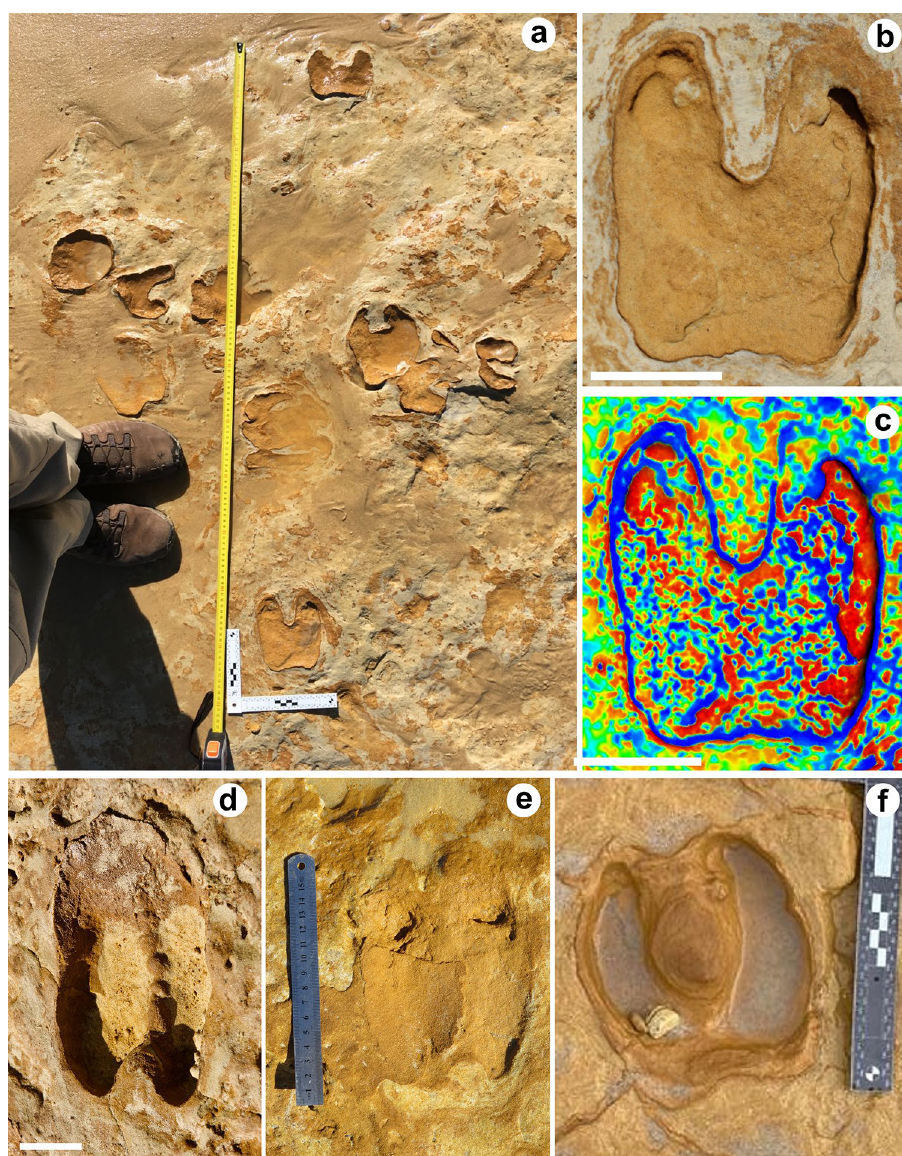
Figure 6. Large artiodactyl tracks from the MTS. ( a ) Trackway T1 attributed to aurochs based on the large size of the squared tracks and the preservation of the dewclaws as rectangular imprints; ( b ) 3D model of a tetradactyl track from the MTS interpreted as Bovinichnus uripeda , vertical view of the texturized 3D model in natural colours; ( c ) vertical view from the previous track made of the false colours DSM (cold and hot colours represent depth gradient, from deeper to shallower, respectively); ( d ) Bovinichnus uripeda , large track; ( e ) manus-pes couple, note the dewclaws; ( f ) large cervid track found in the MTS for comparison, with slender toes with sharp tips, well splayed, with almost linear outlines. Scale bar is 10 cm. The 3D model of the images ( b,c ) were produced by the software Meshroom 2021.1.0 (https:// alice vision. org/# meshr oom); MeshLab 2020.12 (https:// www. meshl ab. net/); CloudCompare 2.11.0 (https:// www. danie lgm. net/